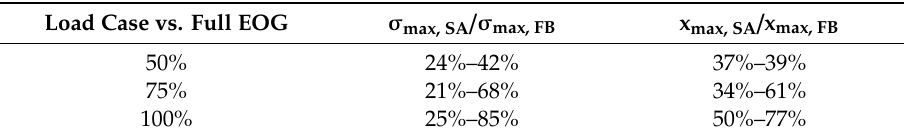
Table 6. Range of demand reduction against the three load cases for the range 10–100 ms of latency in measurements for